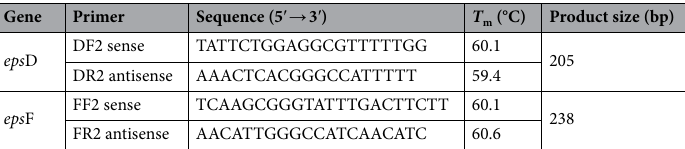
Table 2. The primers used for the amplification 55